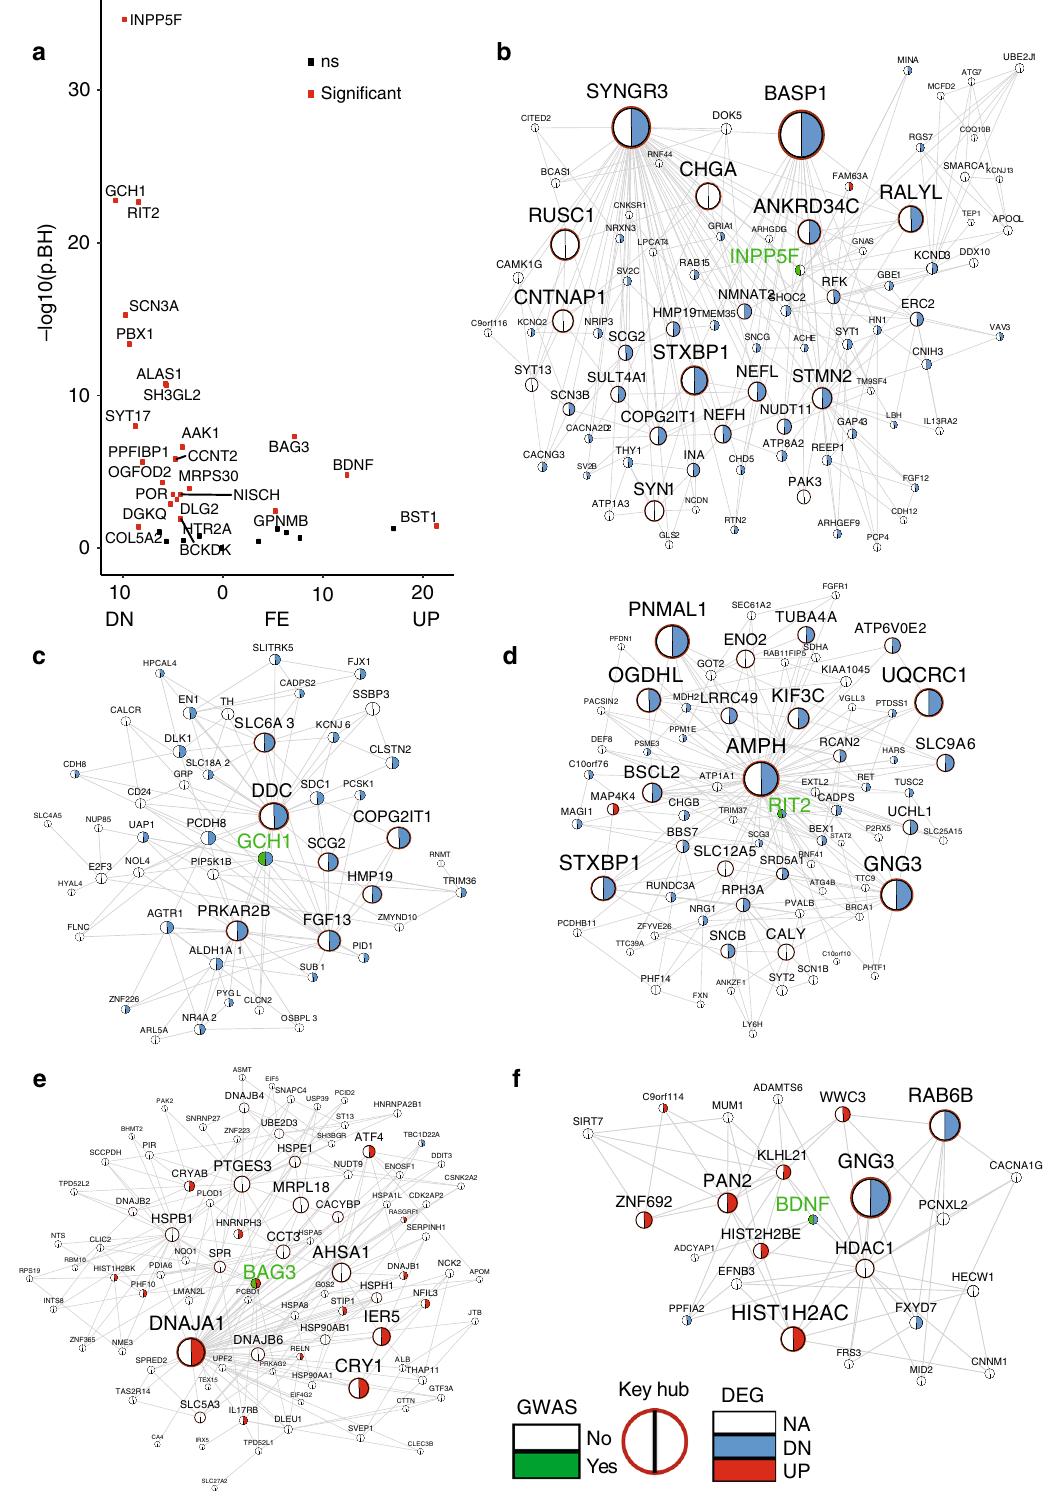
Fig. 2 The subnetworks of the top-ranked PD GWAS genes. a Enrichment of the PD DEGs in the network neighborhoods of a subset of the PD GWAS genes. b – e The network neighborhoods of INPP5F, GCH1, RIT2, BAG3, and BDNF , respectively. The pie chart of each node indicates whether it is a DEG or GWAS gene. The size of a node is proportional to the node connectivity in the MEGENA